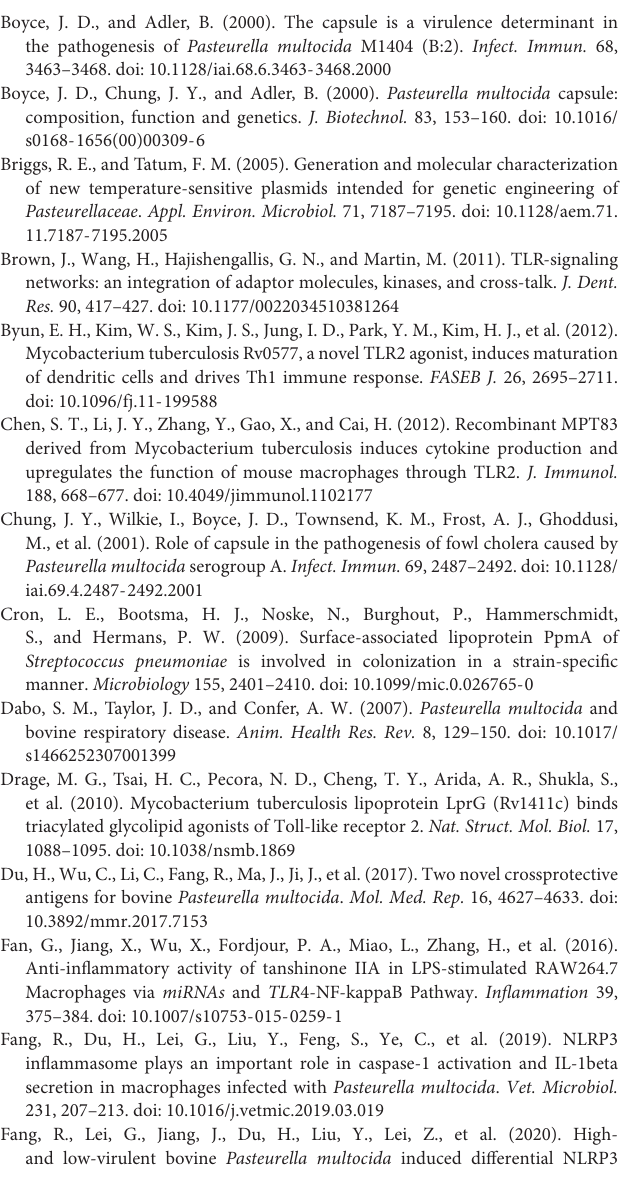
FIGURE S4 | Pm0442 of PmCQ2 plays critical roles in secretion of cytokines in macrophages through TLR2. (A–D) Peritoneal macrophage from C57BL/6 WT, Tlr2 − / − , and Tlr4 − / − mice were left uninfected (UI) or infected with PmCQ2, PmCQ2 (cid:49) 0442, and PmCQ2 (cid:49) 0442/pPm0442 at an MOI of 1, and then the supernatants were collected at 24 h post-infection. The levels of IL-1 β (A) , TNF- α (B) , IL-6 (C), and IL-12p40 (D) in the supernatants were determined by ELISA. The data were pooled from two independent experiments with 8 replicates per group. Panels (A–D) were analyzed by multiple comparative analysis, and expressed as means ± SD ( ∗ p < 0.05, ∗∗ p < 0.01, ∗∗∗ p < 0.001, ∗∗∗∗ p < 0.0001). FIGURE S5 | PmCQ2 (cid:49) 0442 decreased the production of inflammatory cytokines in RAW264.7 macrophages. (A–D) PmCQ2 (cid:49) 0442 reduces a large amount secretion of IL-1 β (A) , TNF- α (B) , IL-6 (C) , and IL-12p40 (D) in RAW264.7. Data